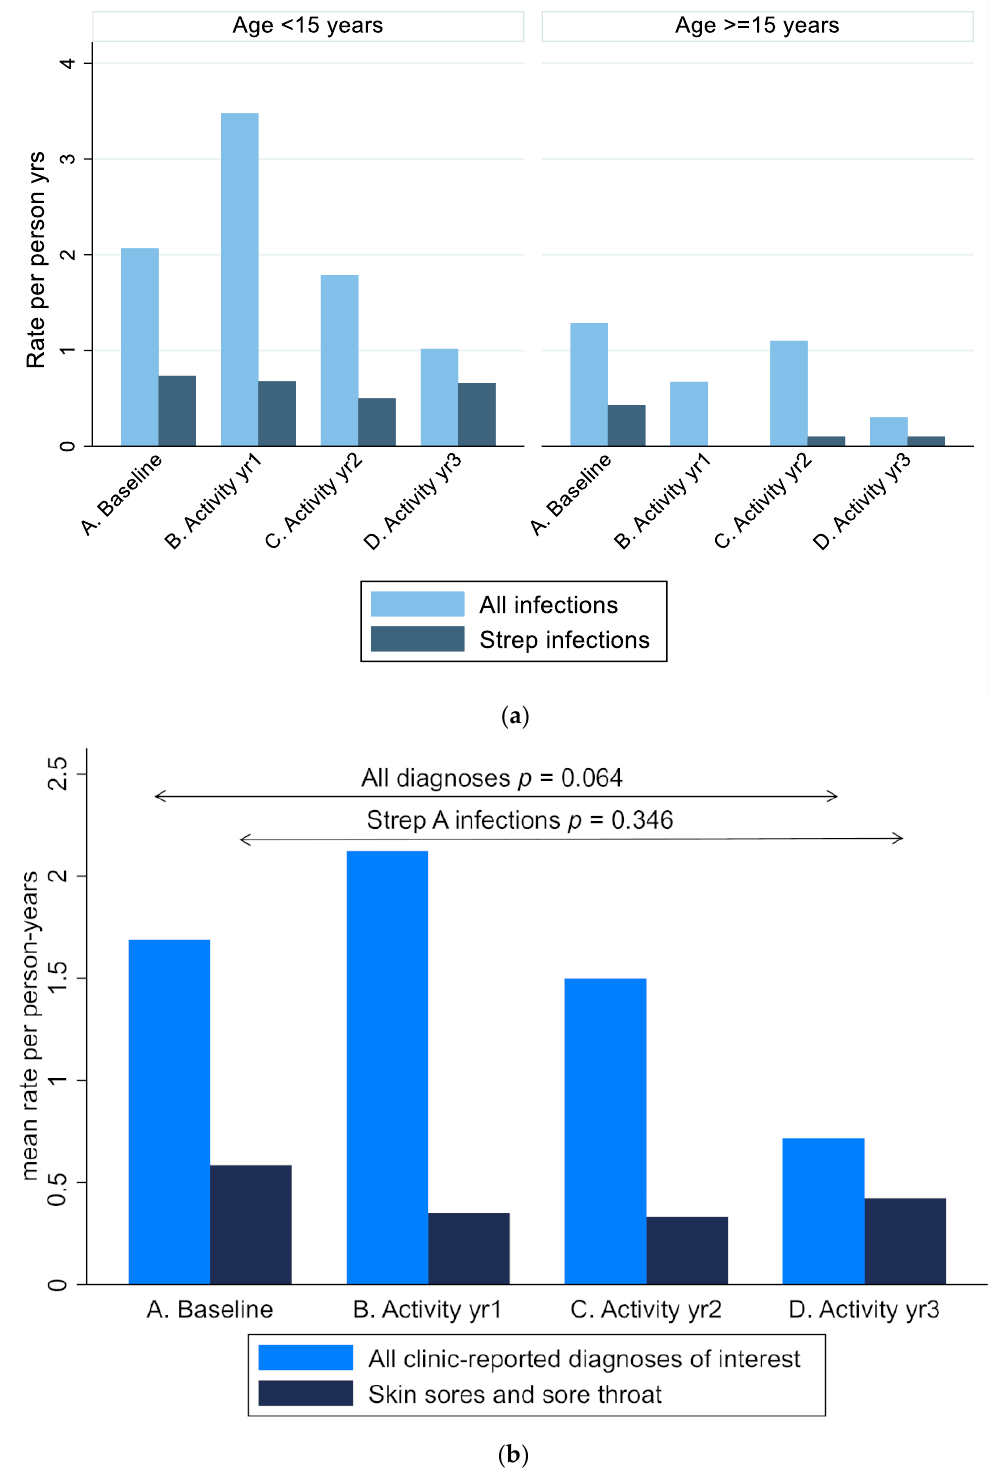
Figure 3. Rates of streptococcal infections in primary study participants. ( a ) By age group; ( b ) All age groups.